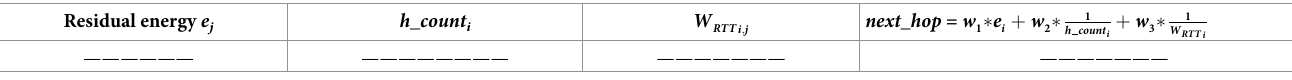
Table 1. Neighbor table. Residual energy e